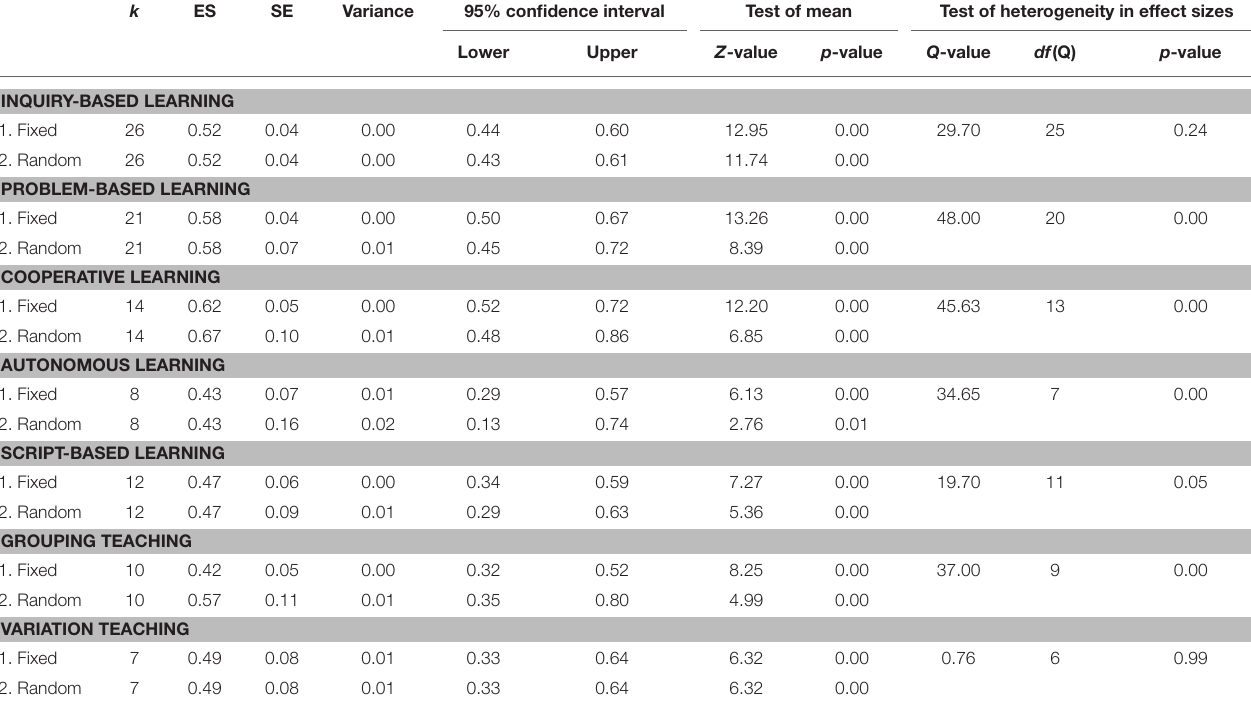
TABLE 5 | Overall effect sizes of seven specific teaching and learning models. k ES SE Variance 95% confidence interval Test of mean Test of heterogeneity in effect sizes Lower Upper Z -value p -value Q -value df (Q) p